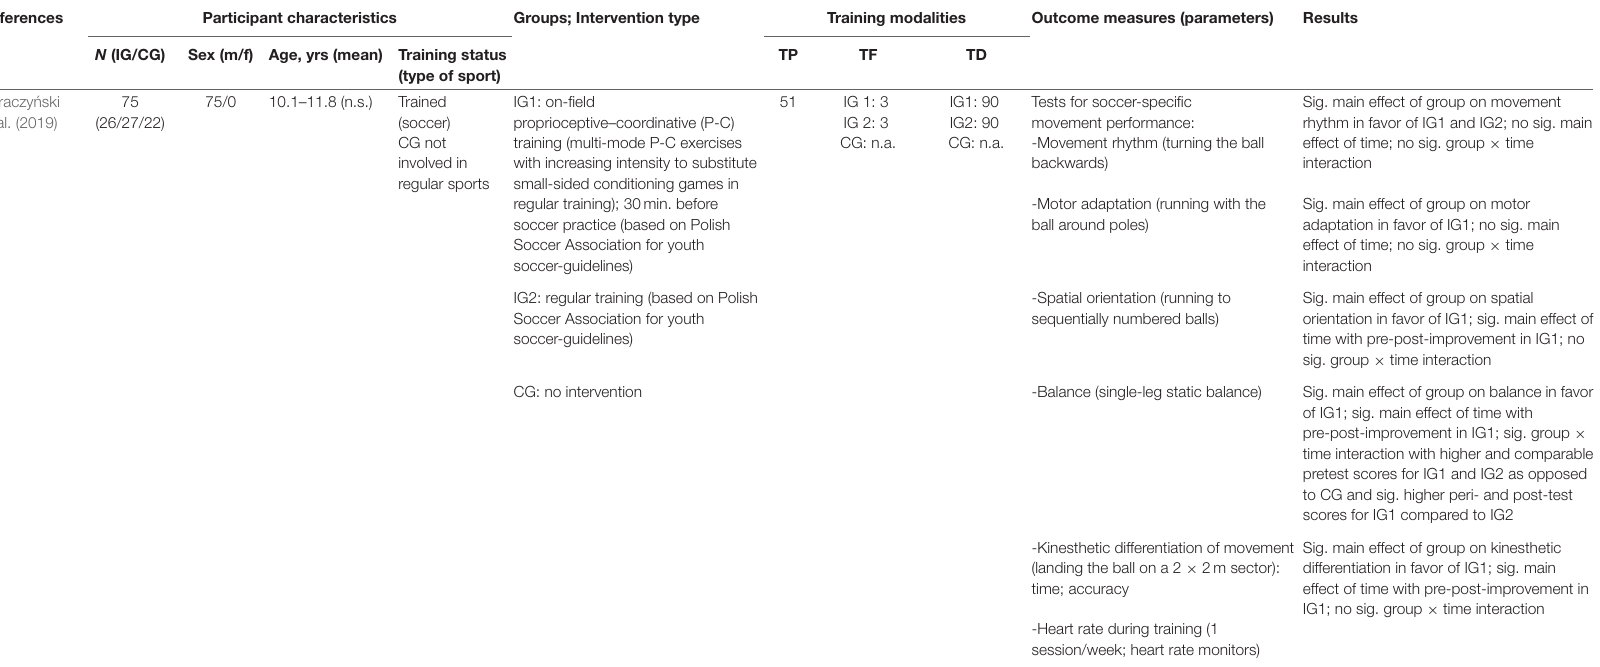
IG2: regular training (based on Polish Soccer Association for youth soccer-guidelines) CG: no intervention -Balance (single-leg static balance) Sig. main effect of group on balance in favor